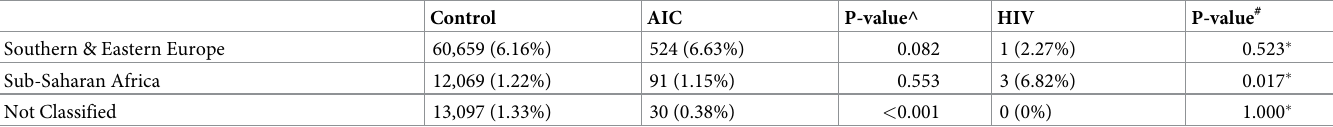
high-grade cytological abnormalities (8.25 vs 6.26 per 1,000 person-years, AHR = 1.33, p = 0.051), and significantly higher rates of low-grade cytological abnormalities (26.03 vs 19.99 per 1,000 person-years, AHR = 1.36, p < 0.001). IBD Females with IBD had significantly higher rates of low-grade cytological abnormalities com- pared to controls (25.30 vs 19.99 per 1,000-person years, AHR = 1.19, p < 0.001). Psoriatic and enteropathic arthropathies. Females with PsA or EA had significantly higher rates of low-grade cytological abnormalities compared to controls (23.73 vs 19.99, AHR = 1.12, p = 0.035).